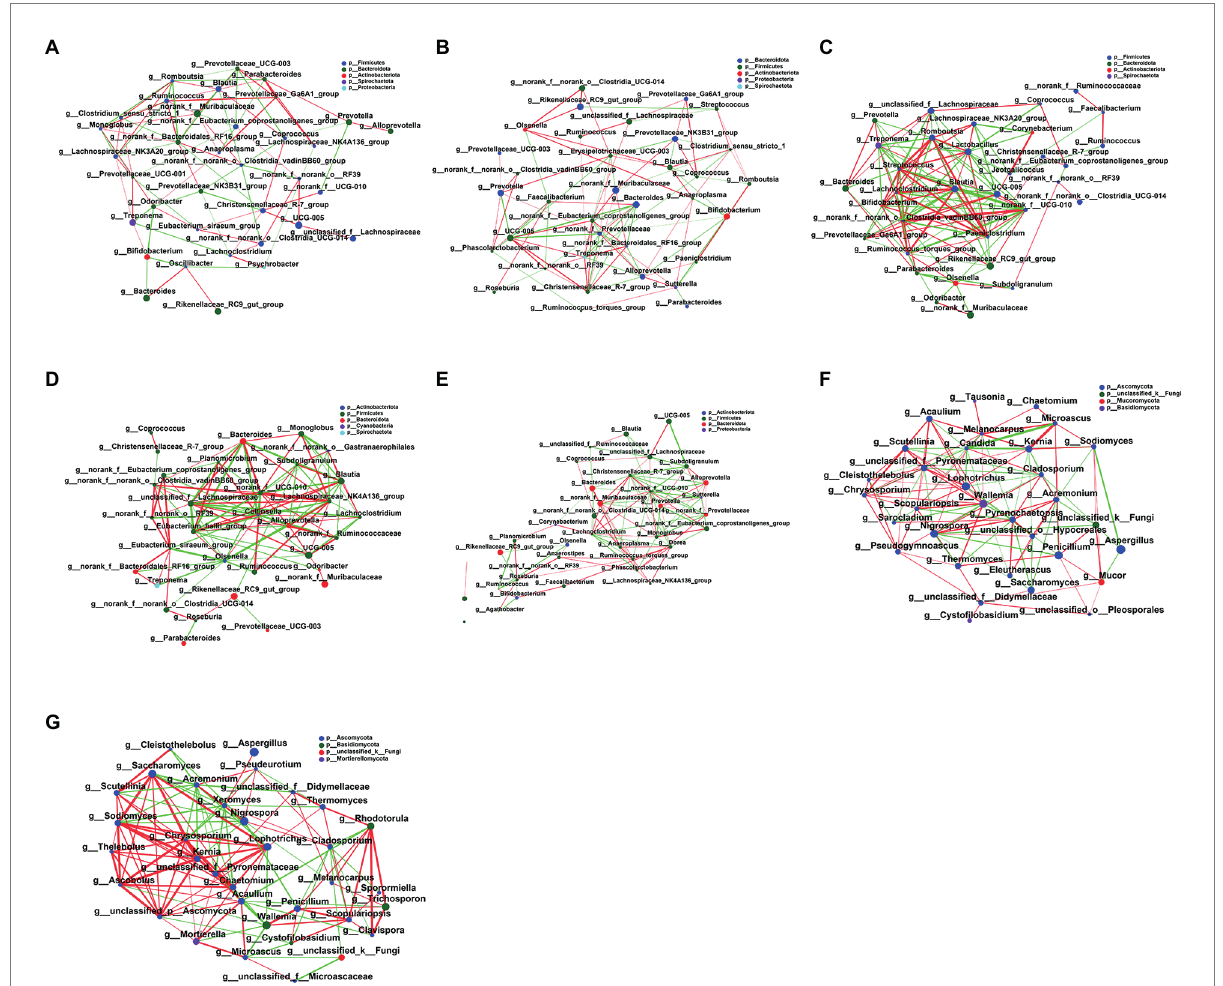
FIGURE 7 Interaction network diagram of fecal microbiota in each group. (A) The network diagram of the interaction between the fecal bacterial microbiota in the NC group. (B) Interaction network diagram of fecal bacterial microbiota in the Control group. (C) Interaction network diagram of fecal bacterial microbiota in LFMT group. (D) Interaction network diagram of fecal bacterial microbiota in HFMT group. (E) Interaction network diagram of fecal bacterial microbiota in SFMT group. (F) The network diagram of the interaction between fecal fungi in the Control group. (G) Interaction network diagram of fecal mycobiota in the LFMT group. The size of the nodes in the figure represents the abundance of species, and different colors represent different species; the color of the connection line represents positive and negative correlation, red represents positive correlation, and green represents negative correlation; the thickness of the line represents the magnitude of the correlation coefficient, the line Thicker lines indicate higher correlations between species; more lines indicate closer connections between the species and other